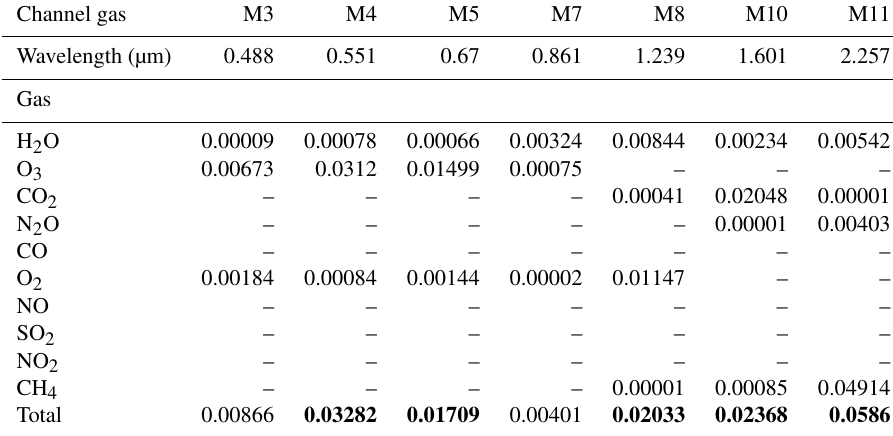
Table 3. Optical depth of major atmospheric gases in seven VIIRS